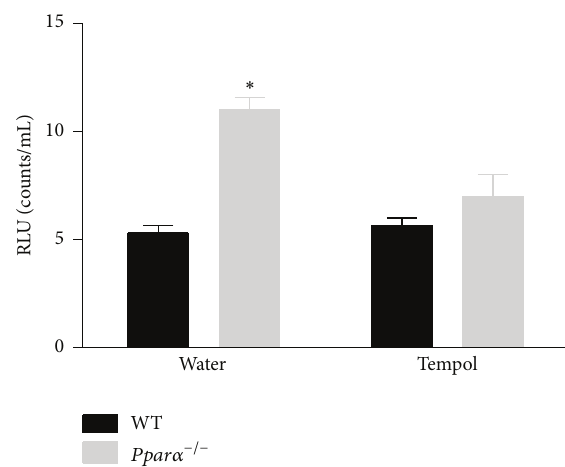
Figure 5: Elevated superoxide levels in Ppar 𝛼 −/− mice are reduced following tempol treatment. Lucigenin- (5 𝜇 M) enhanced chemilu- minescence in mouse aortic segments from WT and Ppar 𝛼 −/− mice after two weeks of treatment with water and tempol. Elevated levels ofsuperoxidein Ppar 𝛼 −/− micewerereducedtothelevelofWTmice after tempol treatment. ∗ denotes statistical significance from water treated WT mice ( 𝑝 < 0.05 ; 𝑛 = 3 animals). Data are means ± SEM.